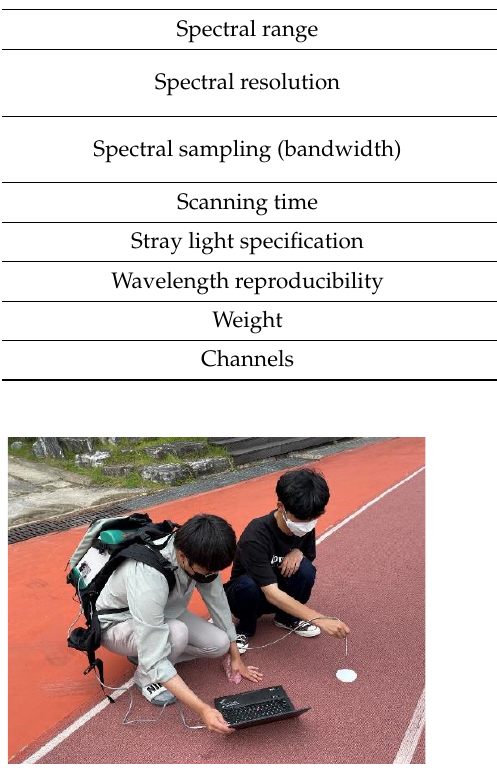
Table 4. Specification of ASD FieldSpec4 spectrometer.